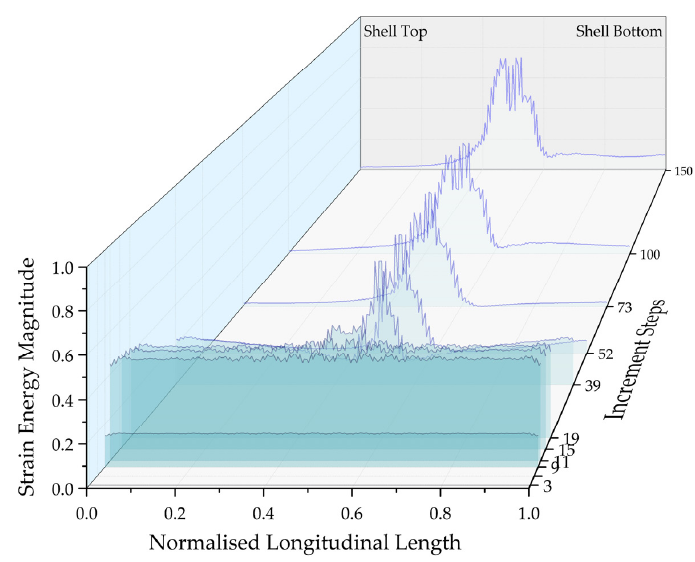
Figure 19. Shell (24 m at 24 mm) strain energy magnitudes along the normalised longitudinal length at typical increment steps, under combined loads.